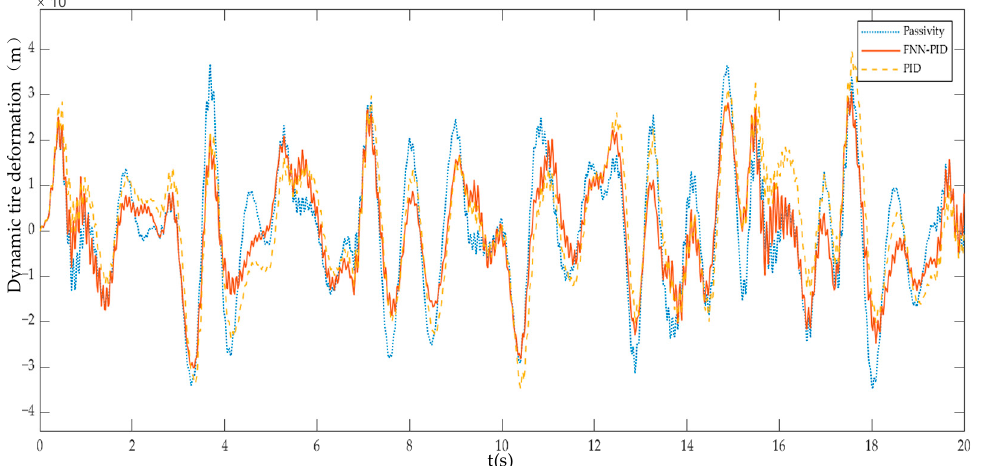
Figure 11. Comparison of Dynamic Tire Deformation simulation results. Table 4. Root mean square comparison of suspension performance indexes under